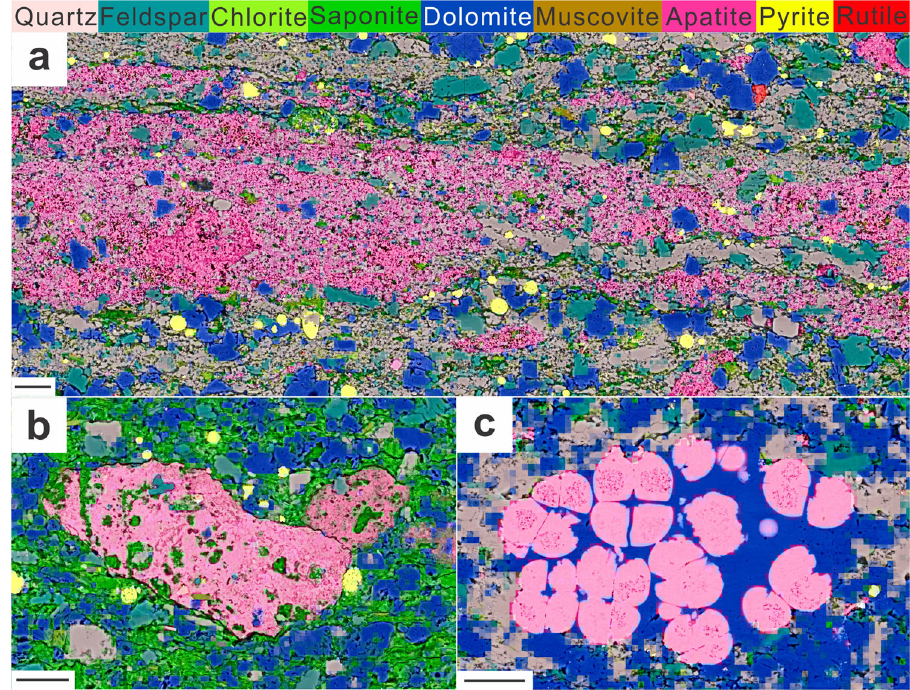
Fig. 6 SEM-EDS mineral mapping images of phosphatic laminae, nodules and fossils. Scale bars represent 20 μ m. a SX22, phosphatic nodules with saponite, feldspar, quartz and dolomite inclusions. b SX4, phosphatic embryo-like fossils resembling Archaeophycus yunnanensis , preserved in a dolomite nodule. c Qlk6, phosphatic laminae associated with micro quartz and other mineral inclusions; framboidal and euhedral pyrite are both Apart from clay minerals, silt-size clastic particles (quartz and feldspar), apatite and pyrite are also common in our samples.